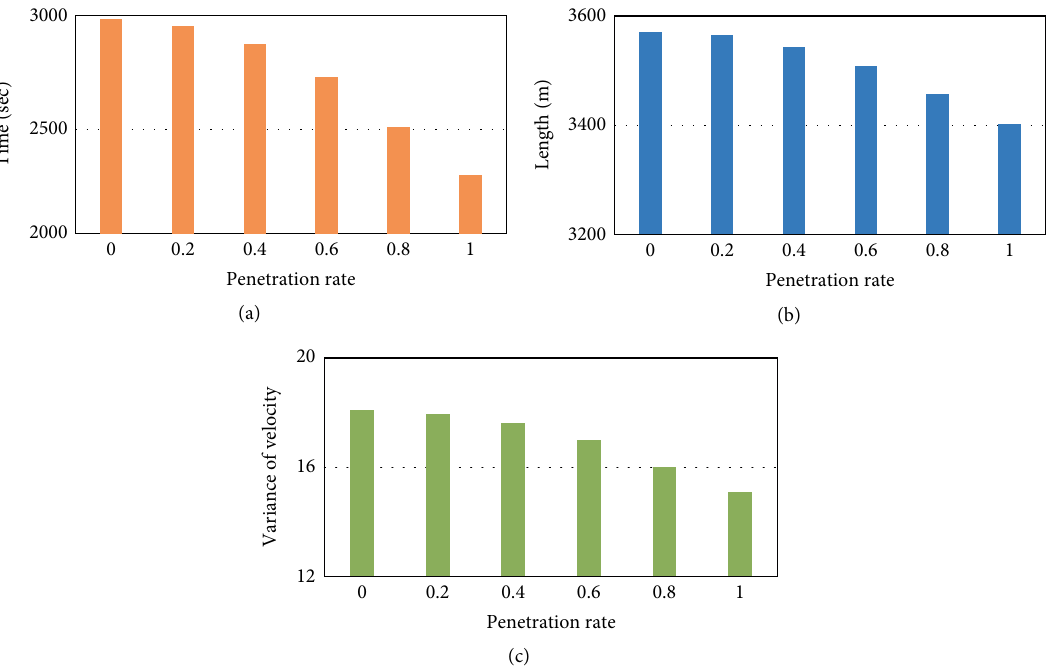
Figure 12: Three indexes of simulations with different penetration rate of CAV. (a) Total stopping time of all vehicles. (b) Road length occupied by vehicles. (c) Variance of velocity of all vehicles.